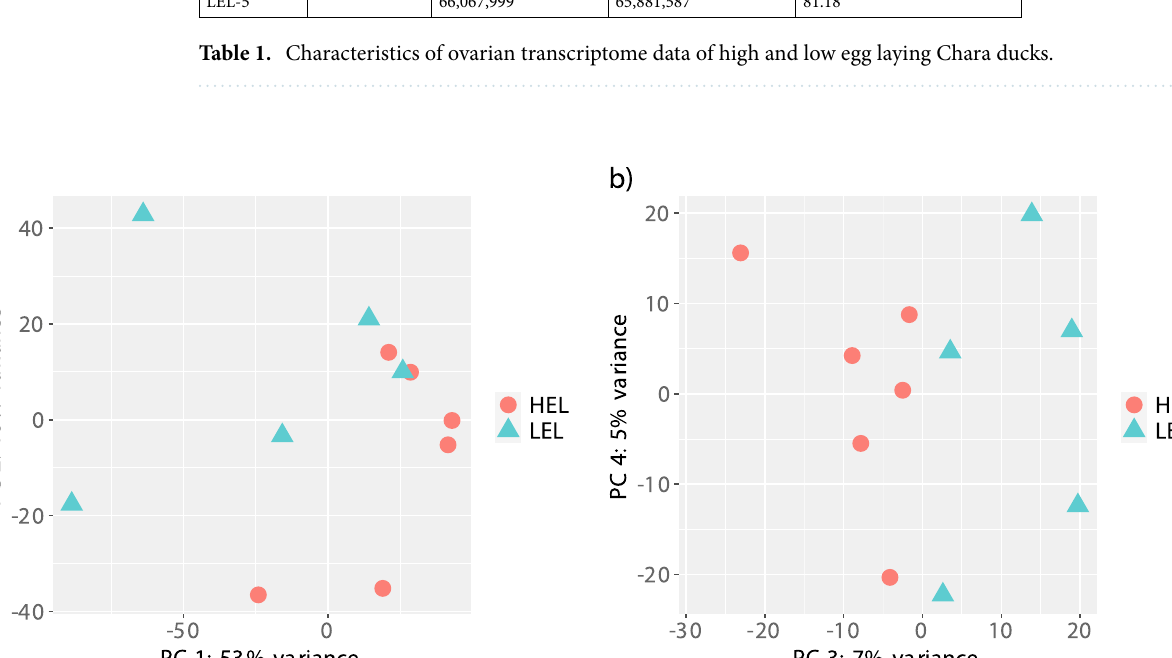
Figure 2. Principal component analysis showing the genetic variation between the HEL and LEL ducks based on transcriptome data. ( a ) PC 1 vs PC 2 and ( b ) PC3 vs PC